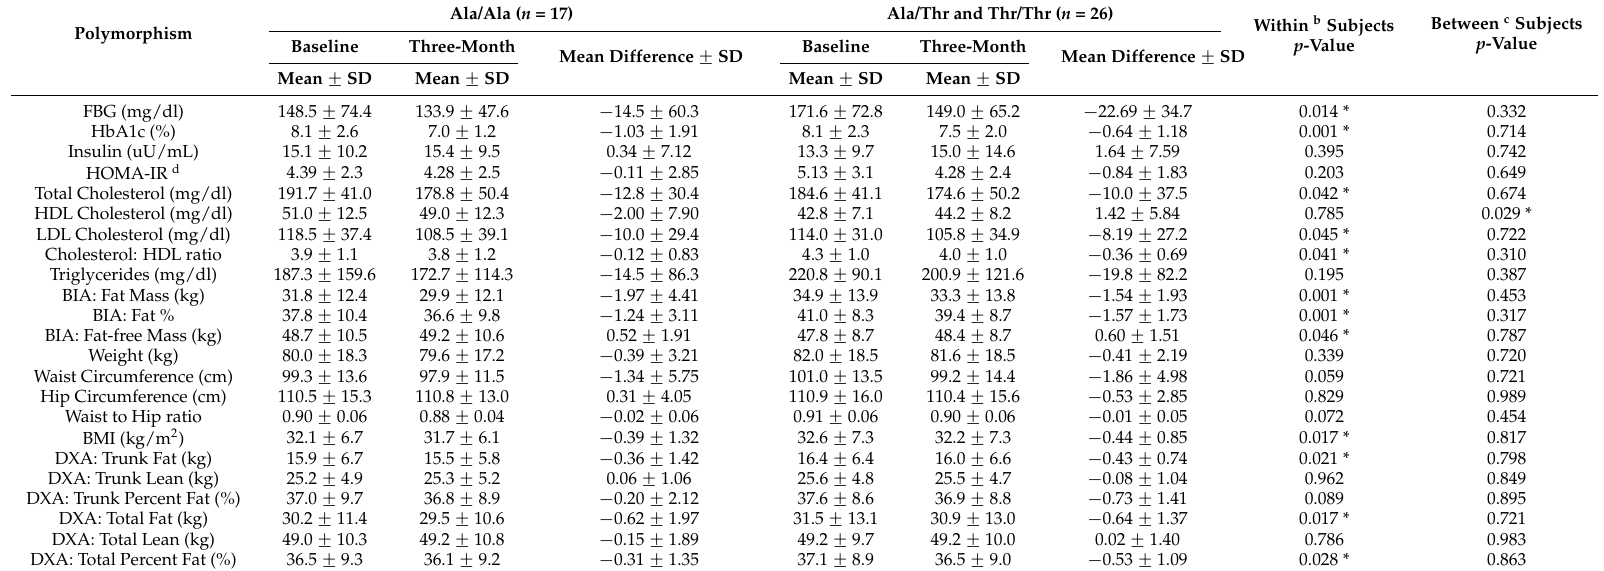
Table 3. Baseline to three-month En Balance participant changes stratified by the FABP2 Ala54Thr polymorphism a